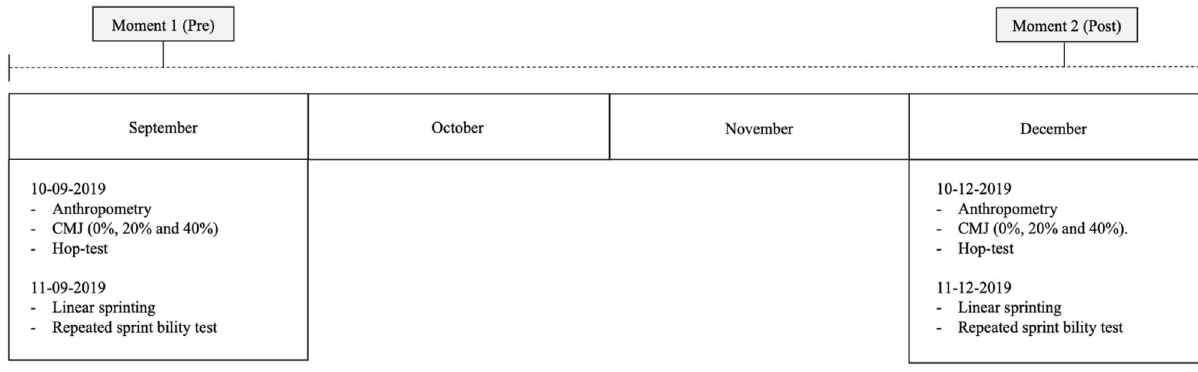
Figure 1. Timeline of the